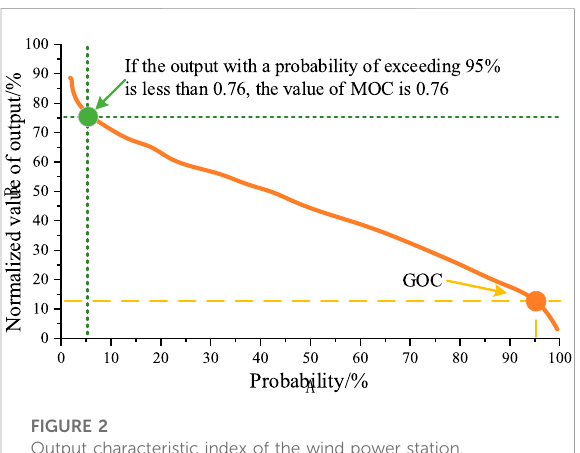
FIGURE 2 Output characteristic index of the wind power